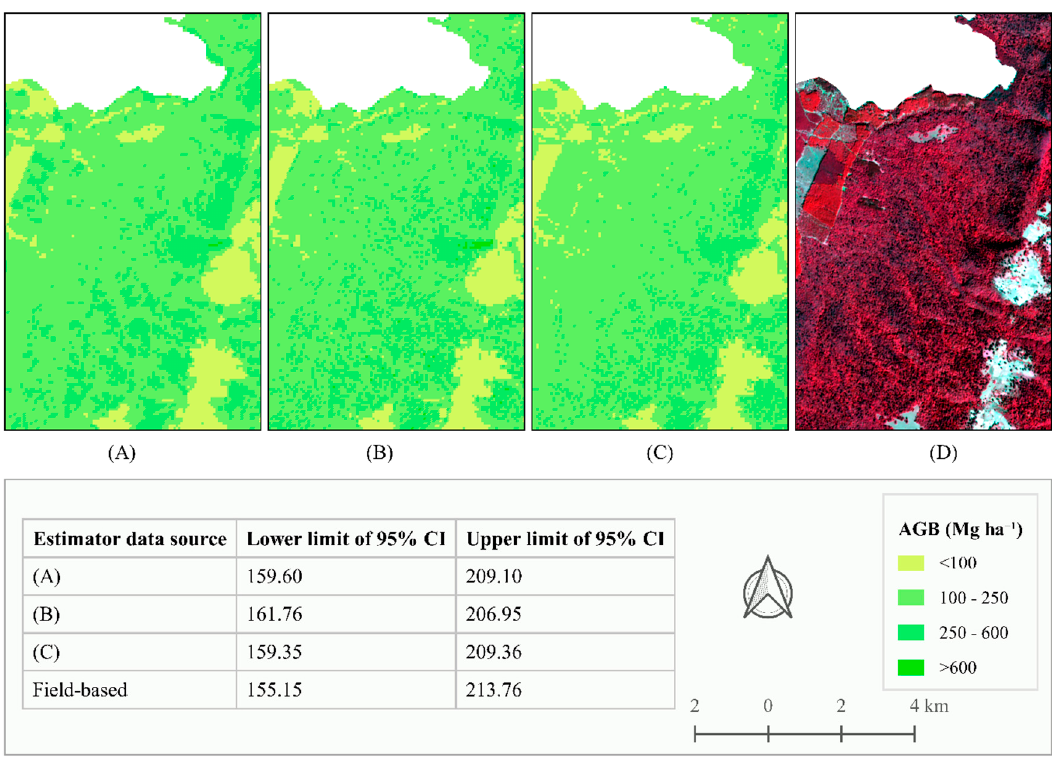
Figure 4. Visual representation of a portion of the predicted AGB using the selected models of ( A ) L8, ( B ) S2, ( C ) PS and ( D ) false-color composite (NIR-R-G in the R-G-B channels) of the S2 image of the study area acquired on 14 January 2019. The 95% CI for the mean AGB estimates of the respective model predictions for the population are shown in the table.